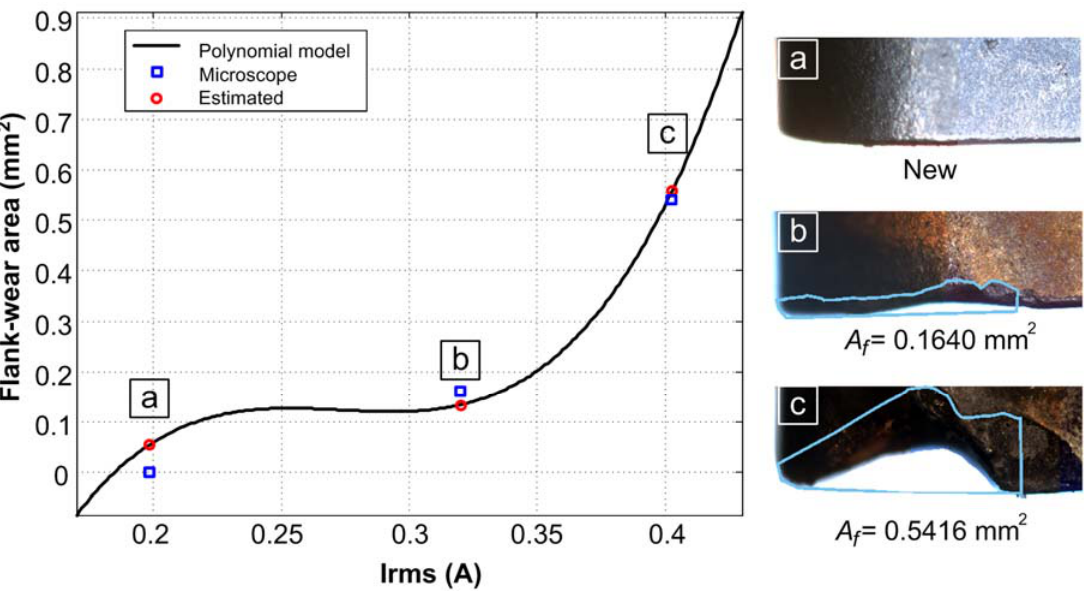
Figure 15. Flank-wear area estimation showing the micrograph of selected inserts and their corresponding tool-wear